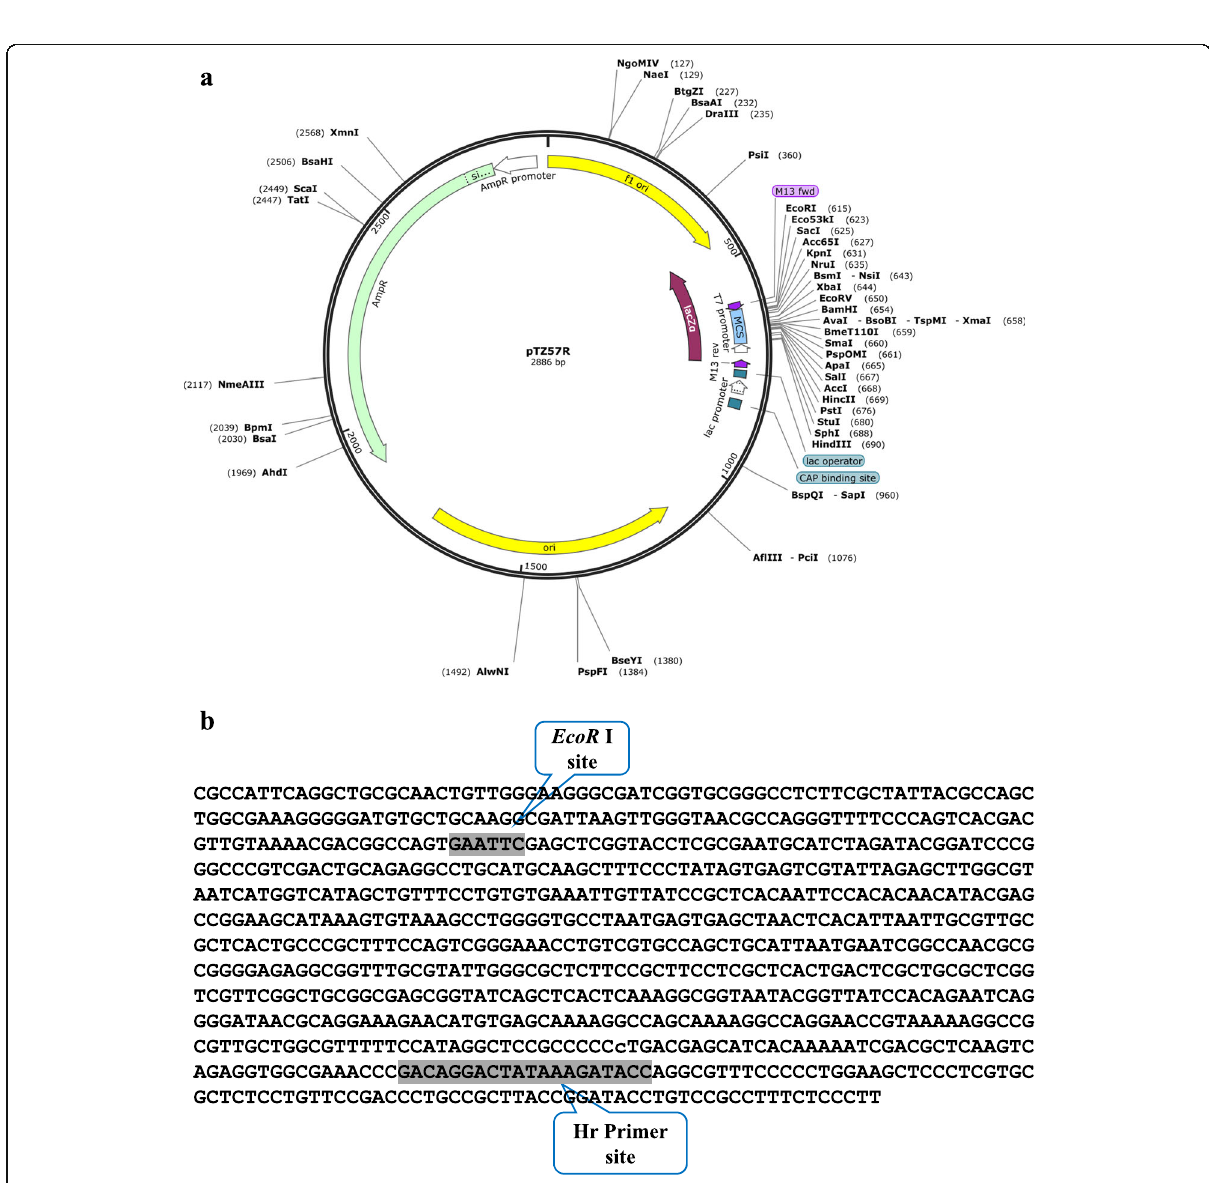
Fig. 2 pTZ57R plasmid. a Map of plasmid and EcoR I restriction site location. b Partial sequence of the plasmid indicating location of EcoR I restriction site sequence and Hr-specific reverse